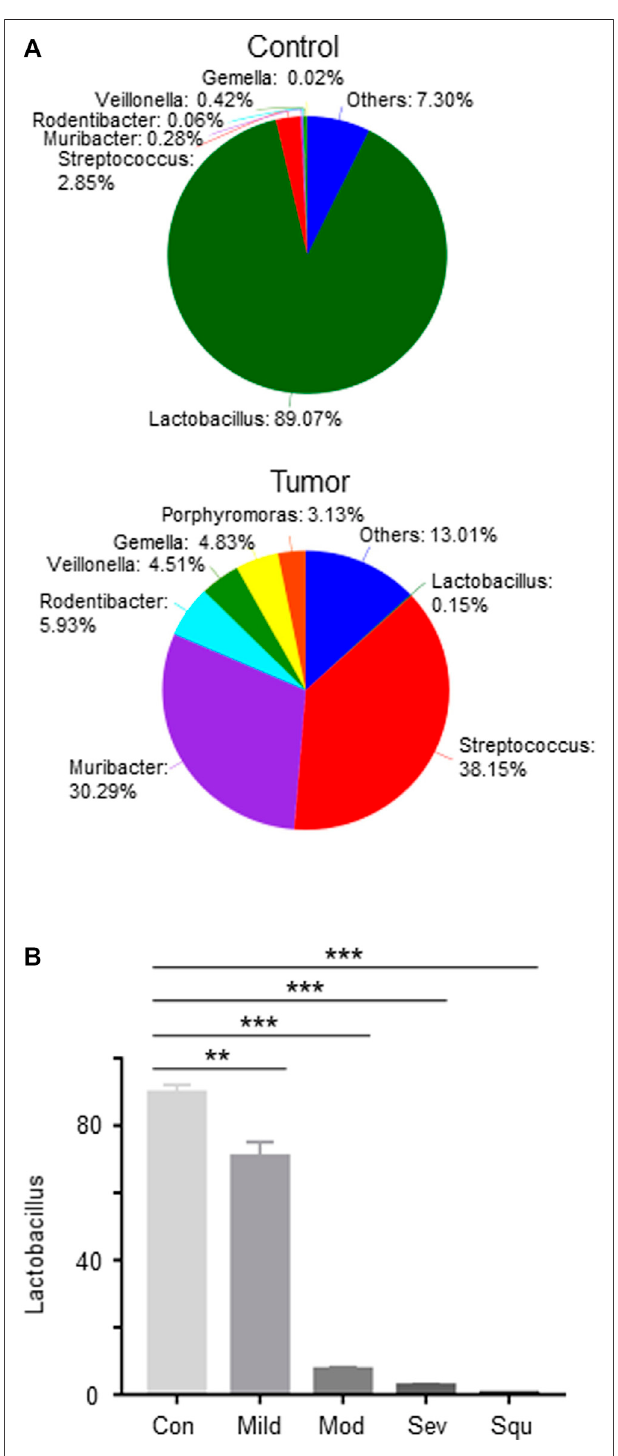
FIGURE 2 | Lactobacillus in the glossopharyngeal tissues of mice with dysplasias and OPCs. Data represent mean ± SEM. ** p < 0.01, *** p < 0.001, n = 3, compared with